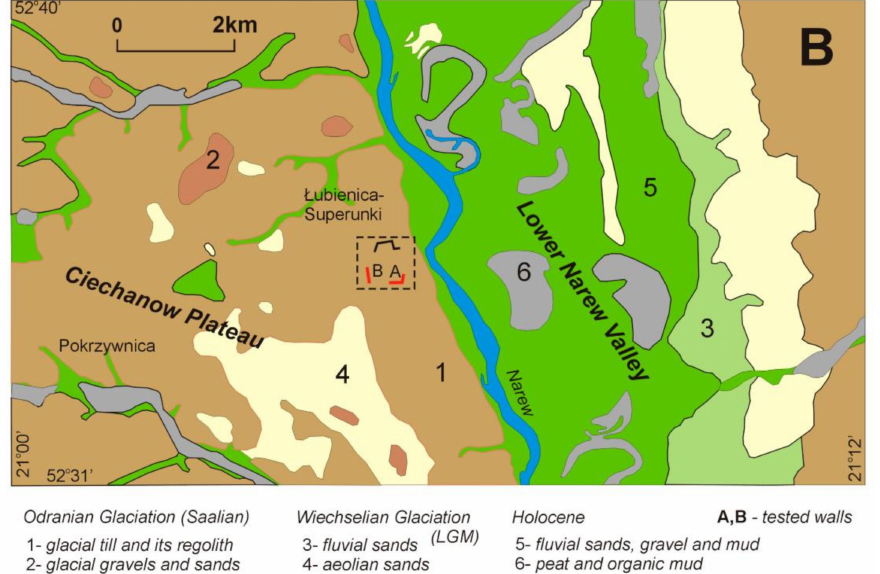
Figure 1. ( A ) Limits of Pleistocene ice-sheets (upon [69,70]) study site (1) and other research sites cited in the discussion: 2–9—[40]; 10—[32,33], 11—[39], 12—[71,72], 13—[42], 14—[41]. ( B ) The location of the tested walls (A and B, in red) in the gravel pit in Łubienica-Superunki against the surface deposits within a fragment of the Detailed Geological Map of Poland (DGMP), 1:50,000 scale, Serock sheet (No. 450). Source: Polish Geological Institute, Institute-National Research Institute, Warsaw, https://geolog.pgi.gov.pl (accessed on: 18 December 2020). The location of the area against the background of the ice-sheet limit of the Wartanian Glaciation and its previously distinguished stadials is shown in ( A